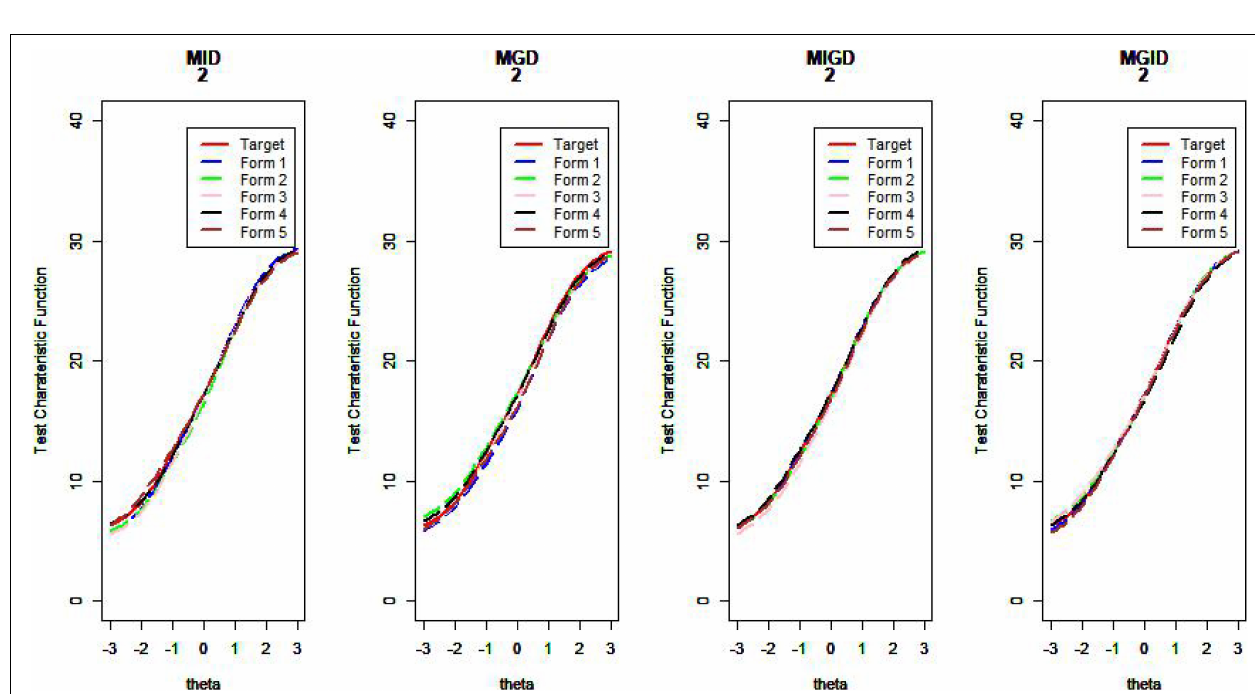
FIGURE 16 | Test characteristic curve ( D =